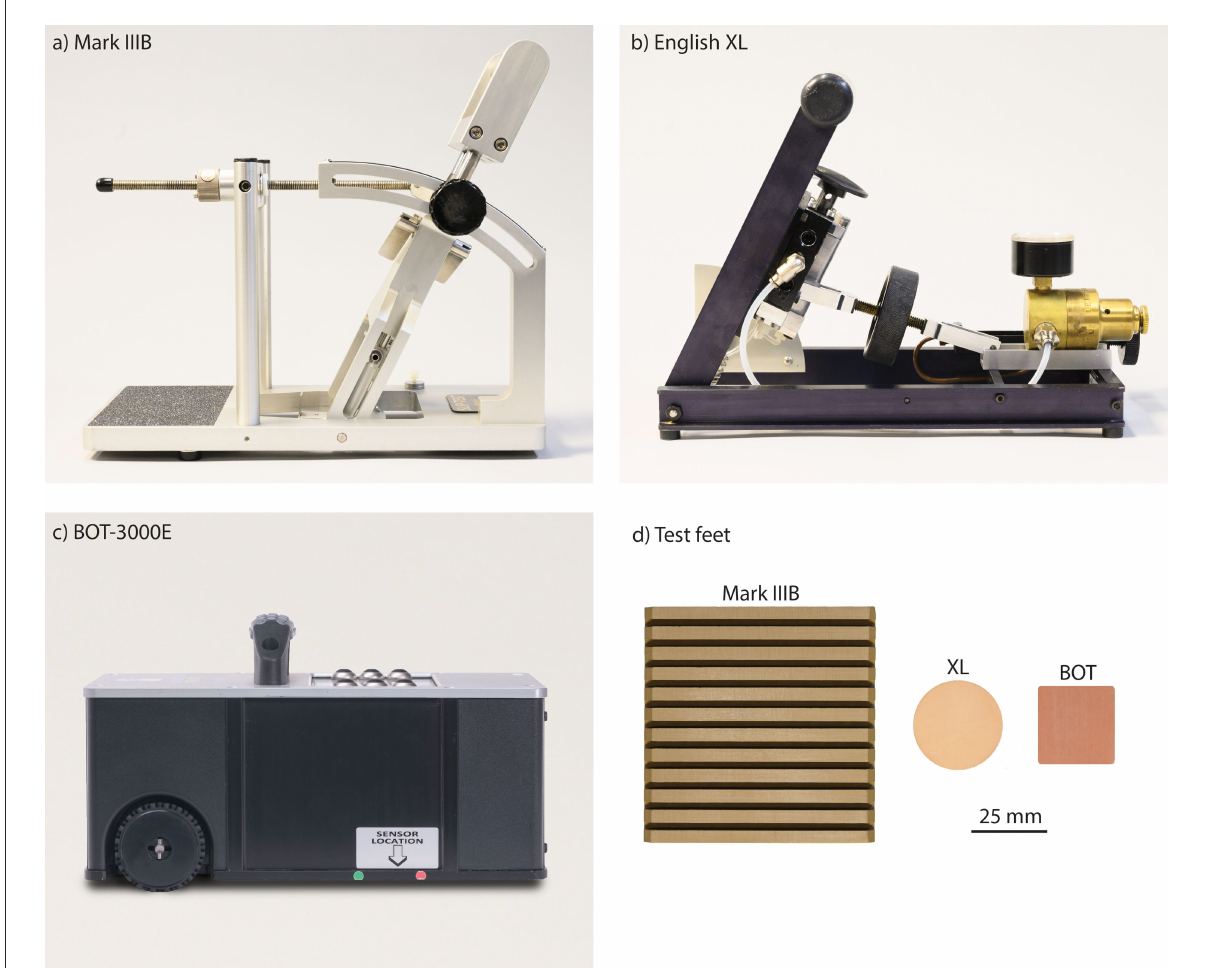
FIGURE1 Walkway tribometers tested: (a) Mark IIIB, (b) English XL, and (c) BOT 3000E. (d) The test feet for the Mark IIIB and English XL were surfaced with Neolite r , and the BOT test foot was surfaced with styrene–butadiene–rubber (SBR). The scale applies only to the panel (d)